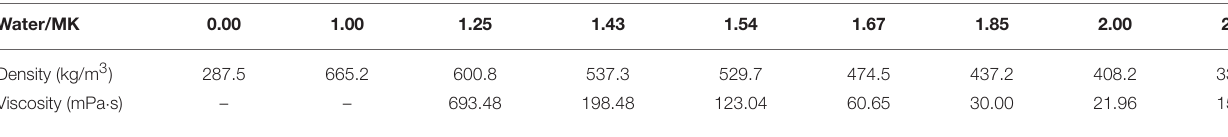
TABLE 5 | Density and viscosity of MK slurry under various water/MK ratio. Water/MK